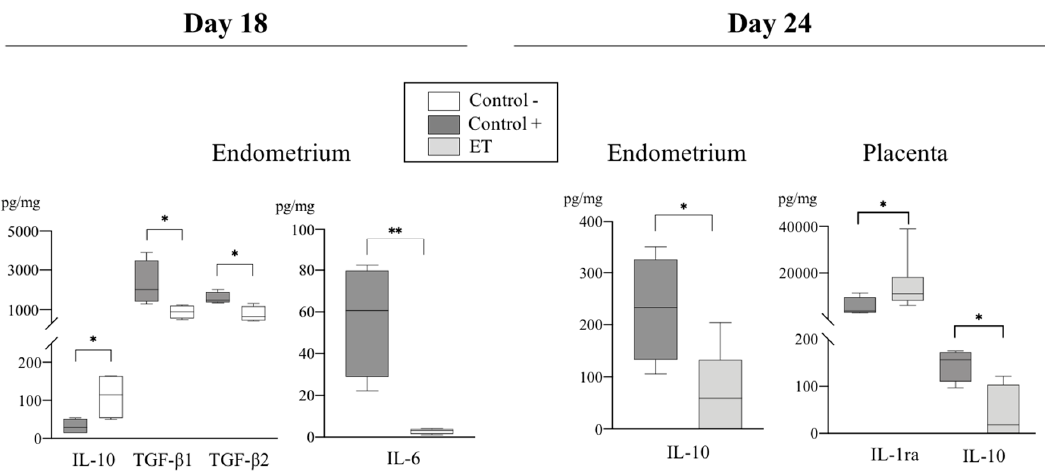
Figure 5. Relative abundance of anti-inflammatory cytokines (pg/mL) with different expression levels in endometrial and placental samples among experimental groups (C + , C − and ET) at Days 18 and 24. Data are presented by box plot showing median and interquartile range (Q1–Q3). Asterisks indicate significant differences among groups (* p < 0.05; ** p < 0.01).